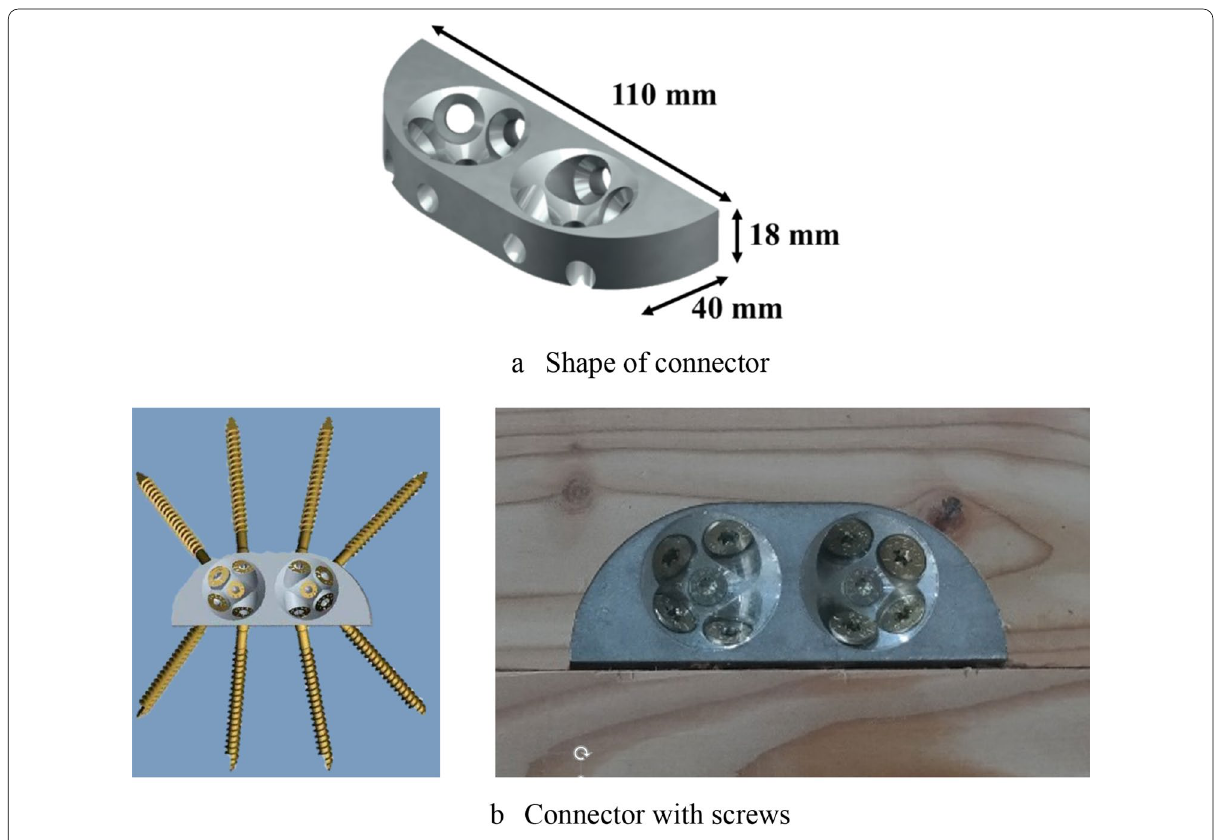
Fig. 2 Configuration of SHERPA CLT‑connector